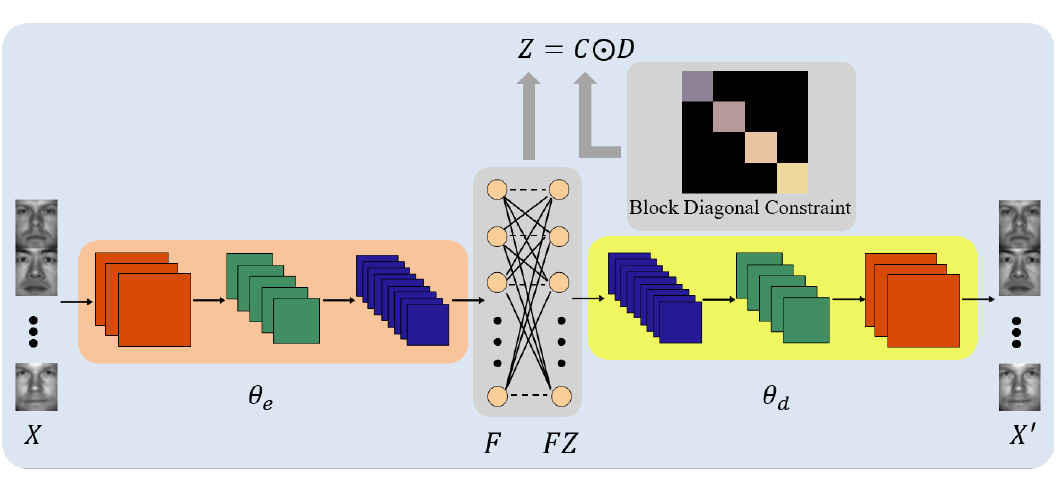
Figure 1. Architecture of the proposed Deep Subspace Clustering with Block Diagonal Constraint (DSC-BDC). It consists of mainly three modules: (a) the convolutional encoder module is used to extract convolutional features, and the parameter is marked as θ e ; (b) the convolutional decoder module is used with the encoder module to initialize the convolutional module, and the parameter is marked as θ d ; and (c) the self-expression module with indirectly block diagonal constraint is used to learn a better representation matrix from the self-expression coefficients, by applying a separation strategy to the representation